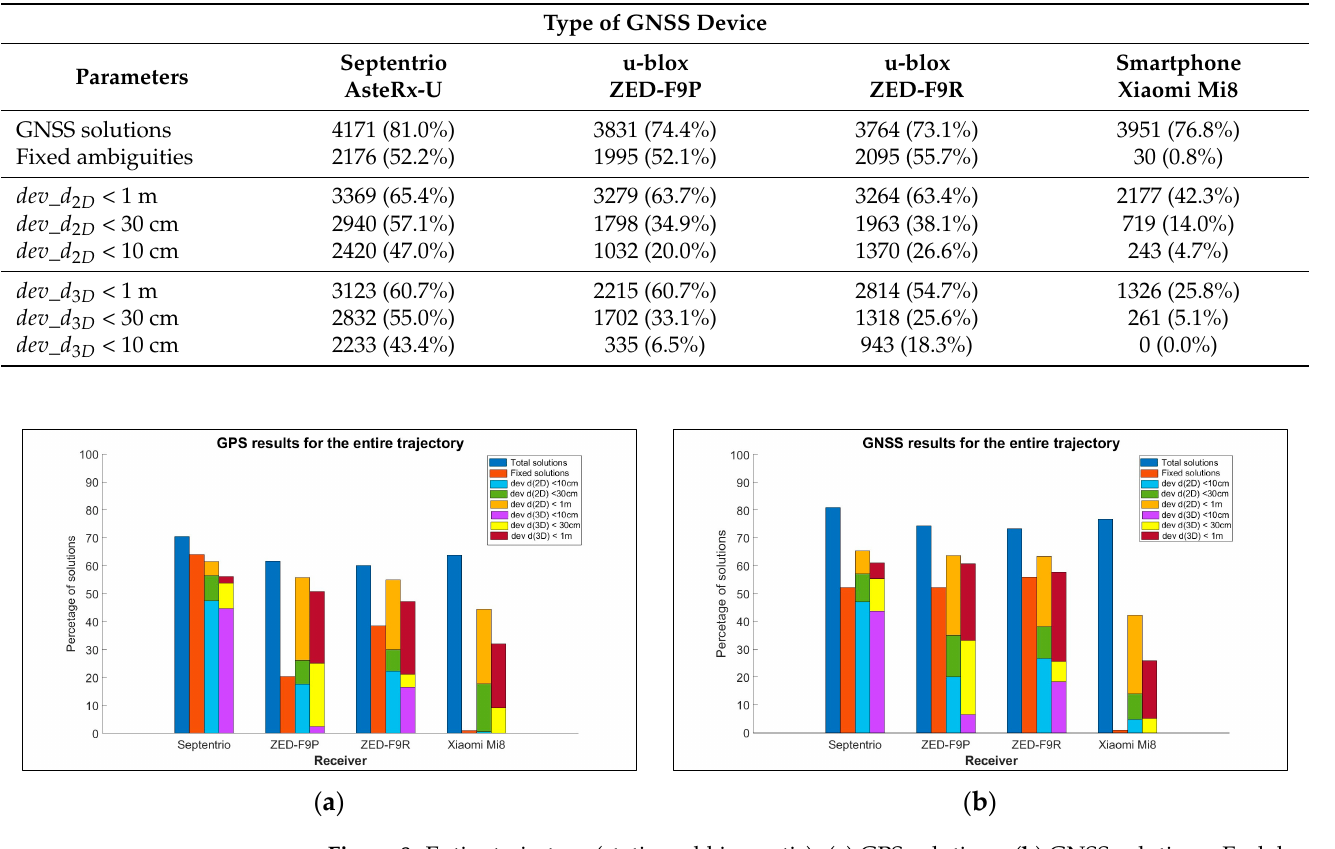
and they were 57% and 48% where the deviations were less than 30 cm and 10 cm, respec- tively. The results are slightly better for the GNSS solutions.